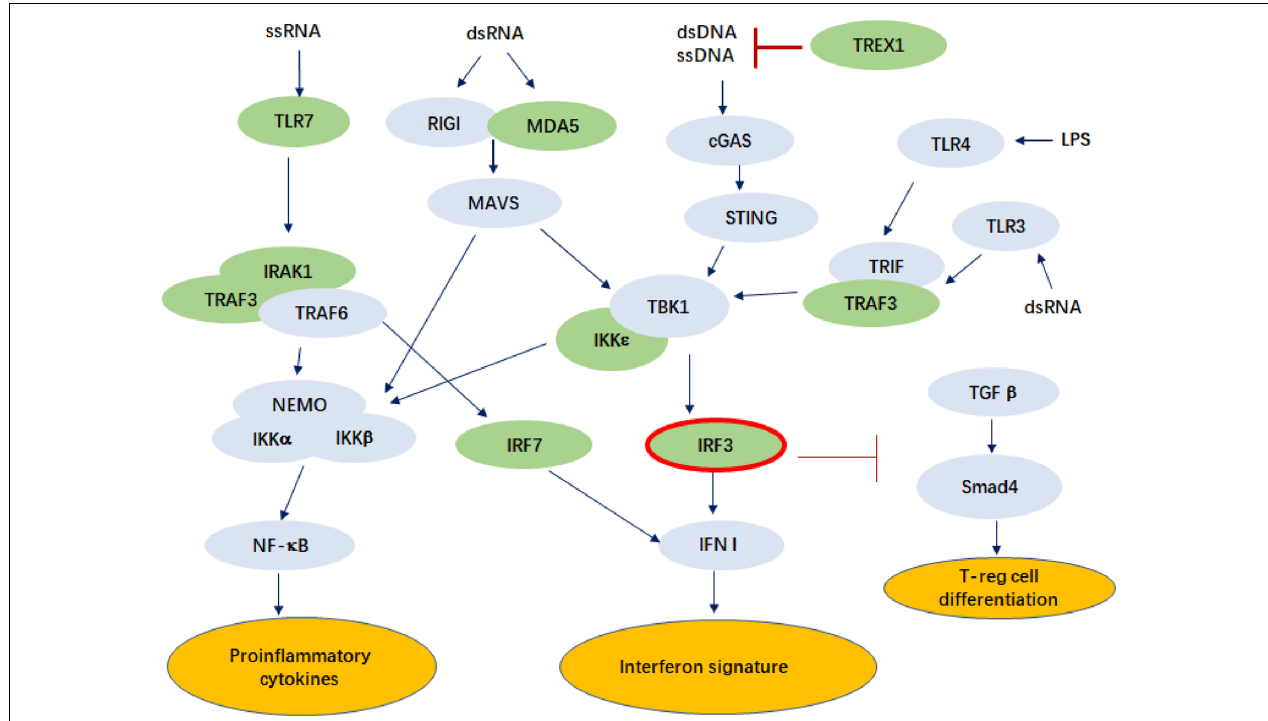
FIGURE 1 | Pathways in which IRF3 is involved that may play a role in the pathogenesis of SLE. The genes known to be associated with SLE are colored in green. ssRNA, single-stranded ribonucleic acid; dsDNA, double-stranded ribonucleic acid; TLR, Toll-like receptor; IRAK1, interleukin-1 receptor associated kinase 1; TRAF3, tumor necrosis factor receptor associated factor 3; NEMO, nuclear factor-kappa B essential modulator; IKK α , I κ B Kinase α ; RIGI, retinoic acid-inducible gene I; MDA5, melanoma differentiation-associated protein 5; MAVS, mitochondrial antiviral signaling protein; cGAS, cyclic GMP-AMP Synthase; STING, stimulator of interferon genes; TBK1, TANK-binding kinase 1; IRF, interferon regulatory factor; IFN I, type I interferon; TREX1, three prime repair exonuclease 1; TRIF, Toll–IL-1 receptor domain-containing adaptor inducing IFN- β ; TGF β , transforming growth factor β ; Smad4, mothers against decapentaplegic homolog 4; LPS,